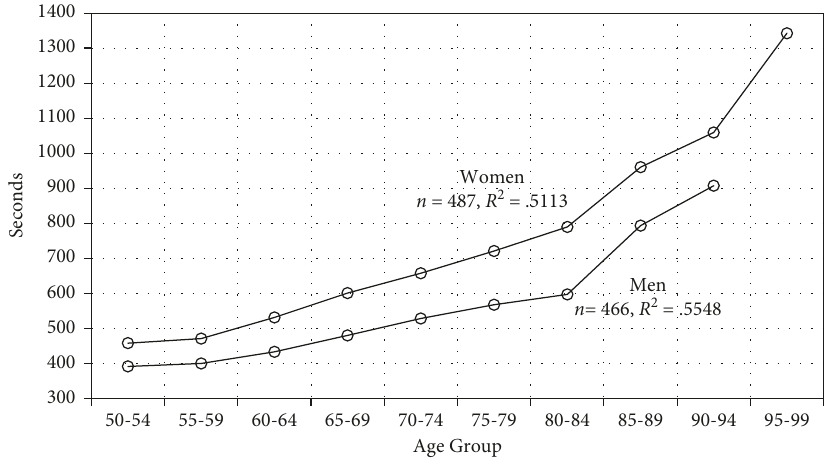
Figure 1: Predicted swim times by age group. Table 3: OLS regressions and solver estimates.